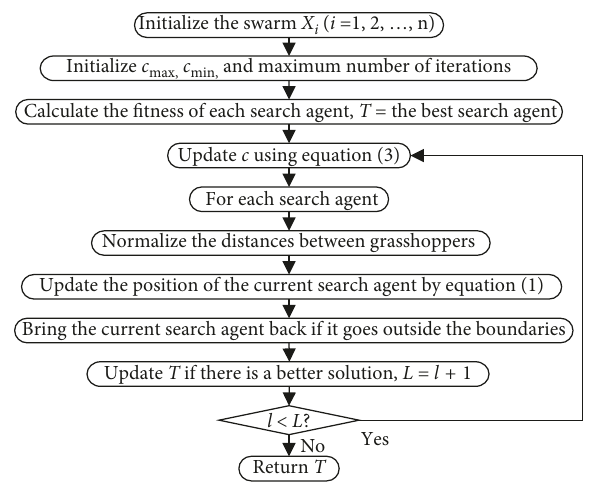
Figure 1: Flowchart of the